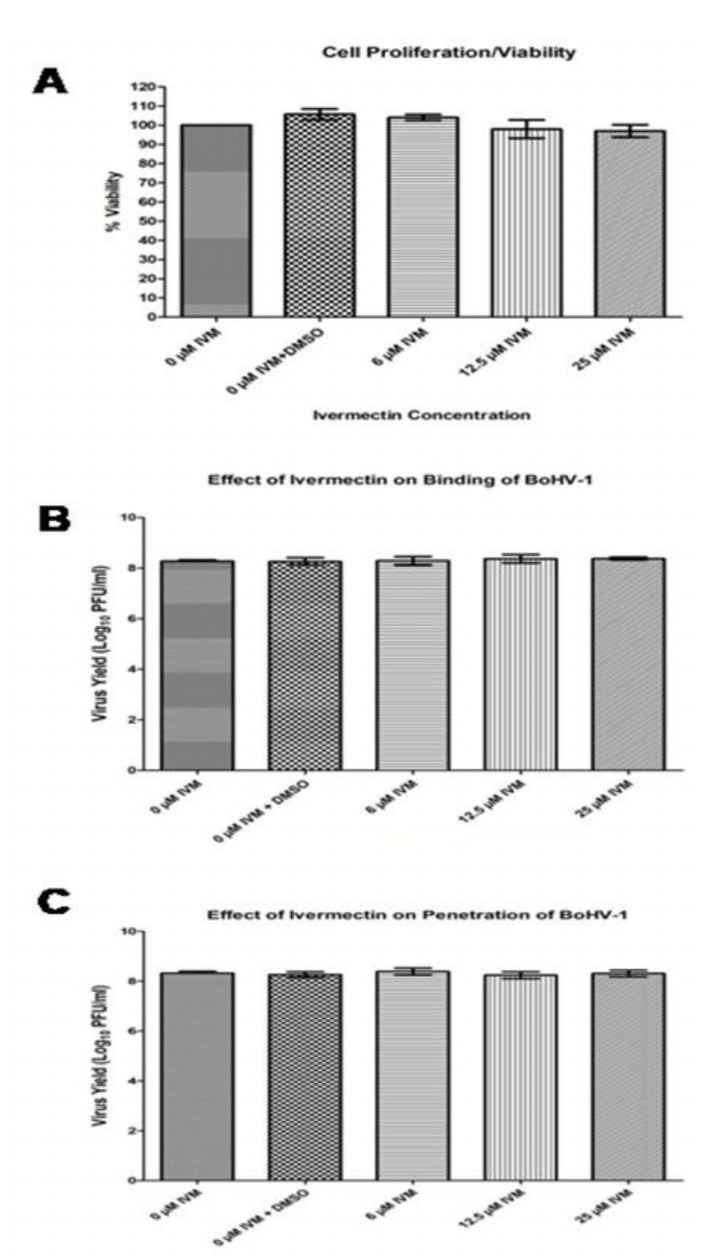
Figure 5. IVM does not a ff ect cell viability, virus binding and internalization. ( A ) MDBK cells were incubated with increasing concentrations of Ivermenctin for 48 h. Cell viability was then measured using an MTT assay. Values represent the mean ± SD of the three independent experiments. ( B ) BoHV-1 was pretreated with various concentrations of IVM at 37 ◦ C for 1 h and incubated with MDBK cells at a MOI of 0.1 PFU / cell at 4 ◦ C for 1 h. The unbound viruses were removed by washing cells with PBS, and the cells were incubated at 37 ◦ C for a further 48 h. ( C ) MDBK cells were incubated with BoHV-1 at MOI of 0.1 PFU per cell at 4 ◦ C for 1 h; the unbound viruses were removed by washing cells with PBS. Then the cells were treated with increasing concentrations of IVM, and incubated at 37 ◦ C for 30 min. The cells were subsequently washed with citrate bu ff er (pH 3.0) to remove residual viruses and cultured in maintenance media at 37 ◦ C for 48 hrs. The virus production in (B) and (C) was determined by PRAs. Data shown are the mean ± SD from three independent experiments. Statistical significance was calculated using Student’s t test according to * p < 0.05, ** p < 0.01, and *** p <